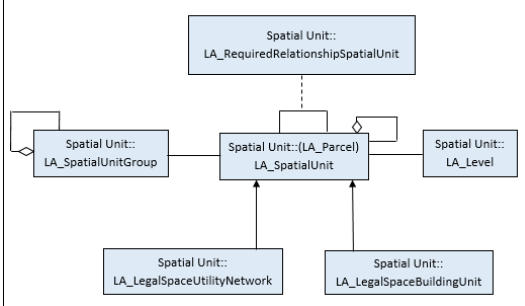
Figure 5. Classes of Spatial Unit Package